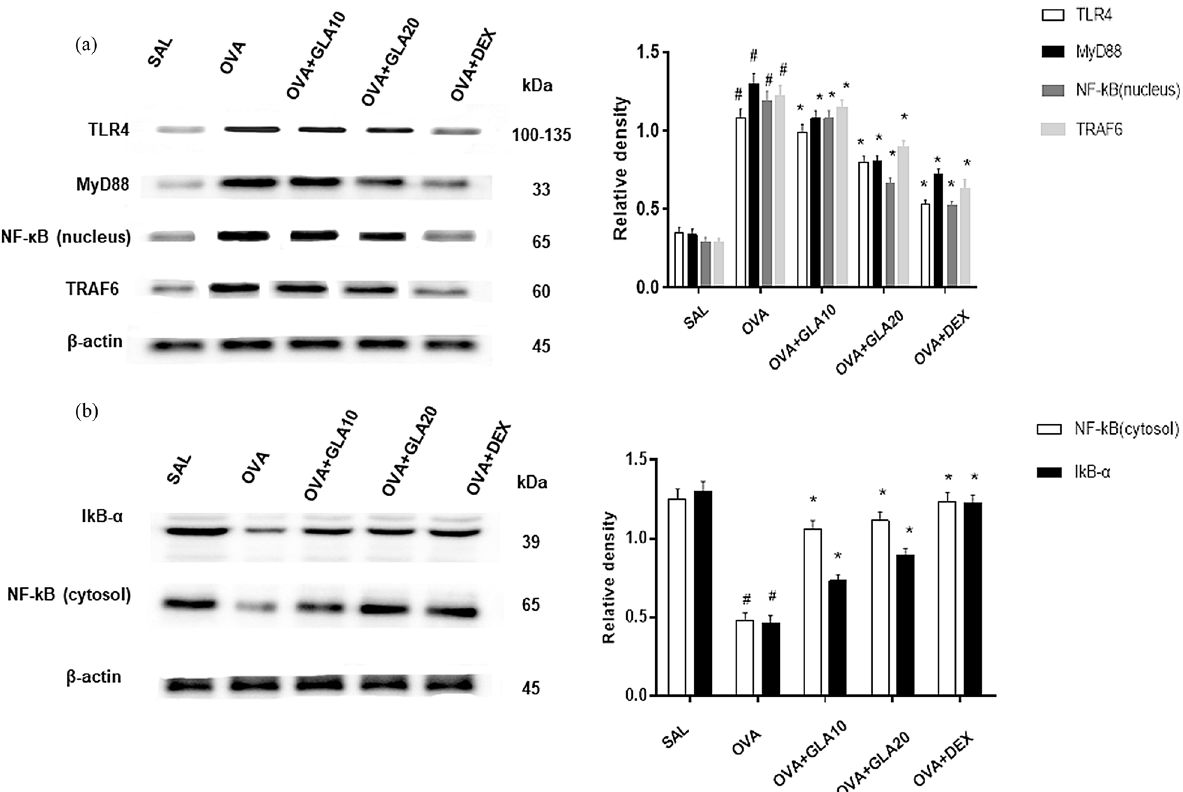
Figure 8: E ff ects of GLA on TLR4, NF - κ Bp65, TRAF - 6, I κ B - α , and MyD88 expression and NF - κ B translocation. ( a ) The protein expression levels of TLR4, NF - κ Bp65 ( nucleus ) , TRAF - 6, I κ B - α , and MyD88 expression, as well as the NF - κ B translocation, in the SAL, OVA - sensitized, Dex ( 1 mg/kg ) , and 10 and 20 mg/kg GLA groups, were detected with Western blot analysis. ( b ) The protein expression levels of NF - κ Bp65 ( cytosol ) and I κ B - α expression, as well as the NF - κ B translocation, in the SAL, OVA - sensitized, Dex ( 1 mg/kg ) , and 10 and 20 mg/kg GLA groups, were detected with Western blot analysis. Compared with the SAL group, # P < 0.05; and compared with the OVA - sensitized group, * P < 0.05. N = 3; analyzed by